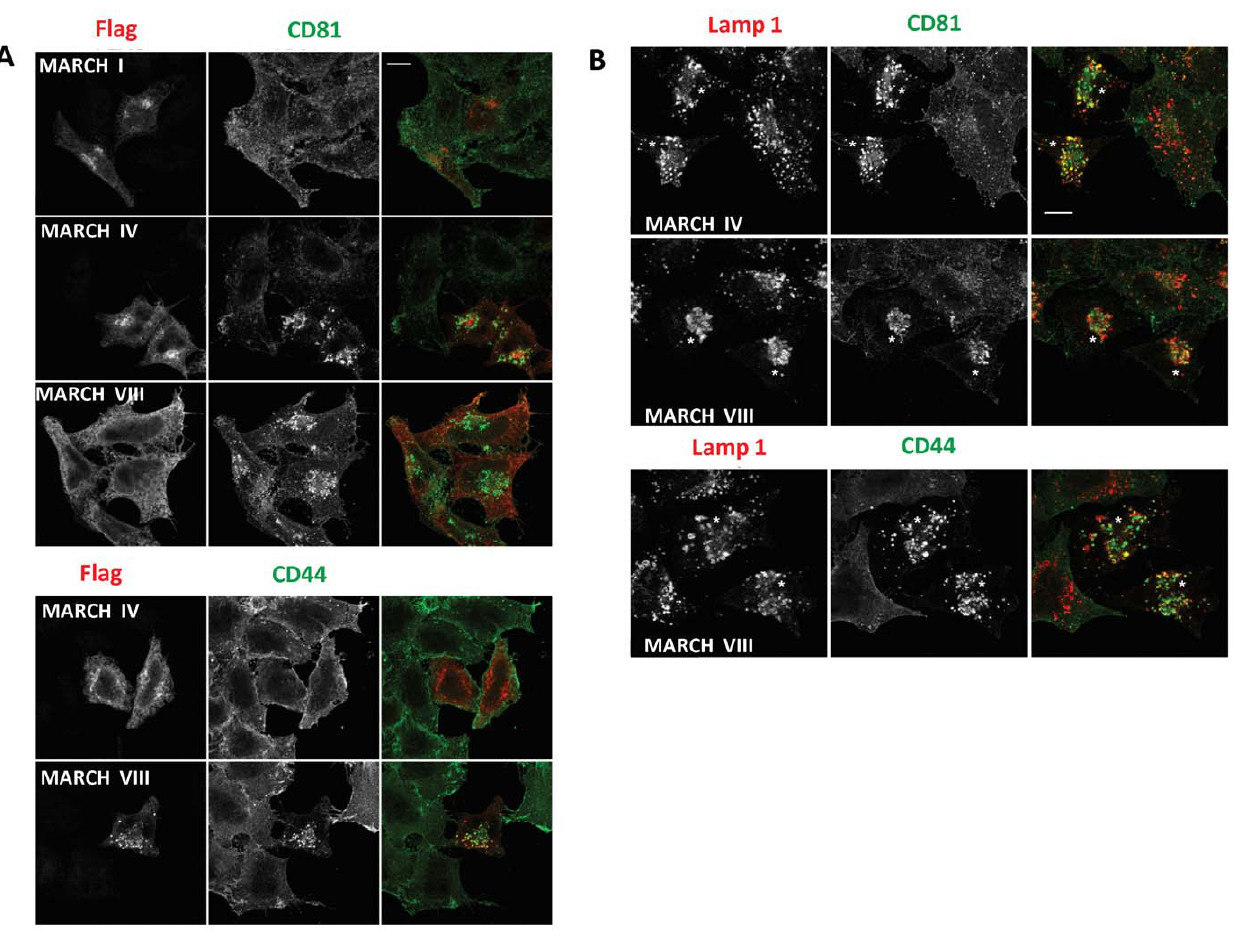
Figure 6. CD81 and CD44 are targeted to lysosomes by MARCH proteins. Flag-tagged MARCH-constructs were transfected into HeLa cells and the cells were treated with 25 mM NH 4 Cl for 2 h. Cells were fixed and stained with anti-Flag and anti-CD81 or anti-CD44 antibodies (A) or stained with either CD81 or anti-CD44 antibodies along with rabbit anti-Lamp1 (B) as described in Materials and Methods. Mouse antibodies were detected with anti-mouse Alexa 488 (green) and rabbit antibodies with anti-rabbit Alexa 594 (red). In B, MARCH-expressing cells, inferred by the altered distribution of CD81 and CD44, are indicated with an asterisk (*). Bar, 10 m m (B).